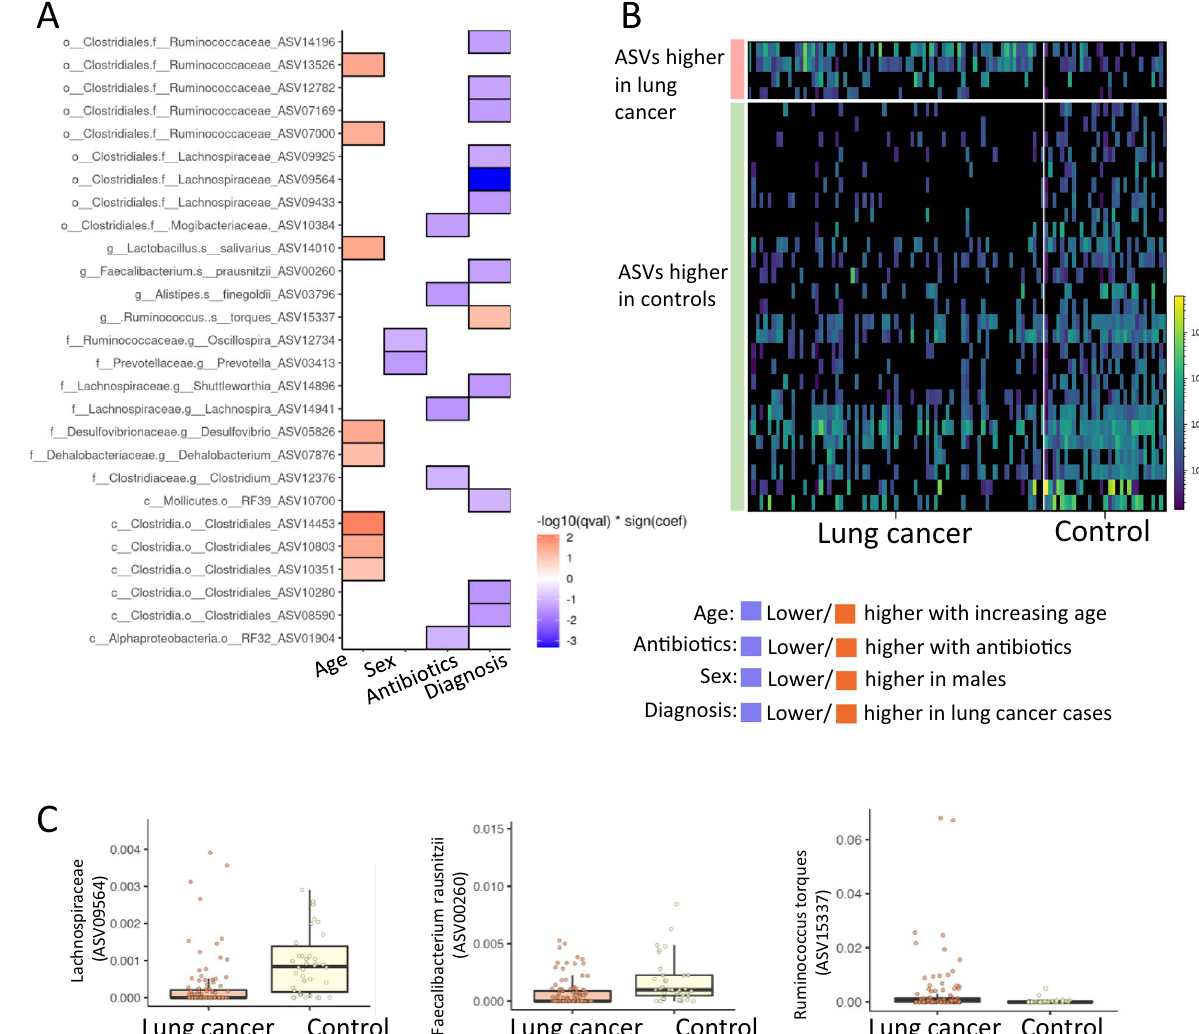
Figure 2. Specific bacterial ASVs linked with LC, after controlling for age, antibiotics, and gender in a multivariate analysis. MaAsLin2 (Multivariate Association with Linear Models) was used to link ASVs to LC in a multivariate model controlling for subject, age, gender, antibiotics. This resulted in 31 bacterial ASVs that showed significant relative differential abundance between LC and controls (FDR correction < 0.25, Dataset S3). ( A) A heatmap showing the specific bacterial ASV found to be significantly associated with age, gender, antibiotic exposure and LC diagnosis in the model with FDR < 0.1. ( B ) Heatmap of all 31 bacterial ASVs that showed differential abundance between LC and controls (FDR correction < 0.25). Each column represents an individual subject, and each row represents a different bacterial ASV. Color scale indicates the relative frequency out of the normalized reads per sample. ASVs heatmaps were generated using Calour software version 2019.5.1. ( C ) Bar graph highlighting the relative abundance in LC vs. controls of the indicated 3 ASVs linked with LC. Box and whisker plots with central line indicating median, box margins representing upper and lower interquartile region (IQR), and whisker indicates additional